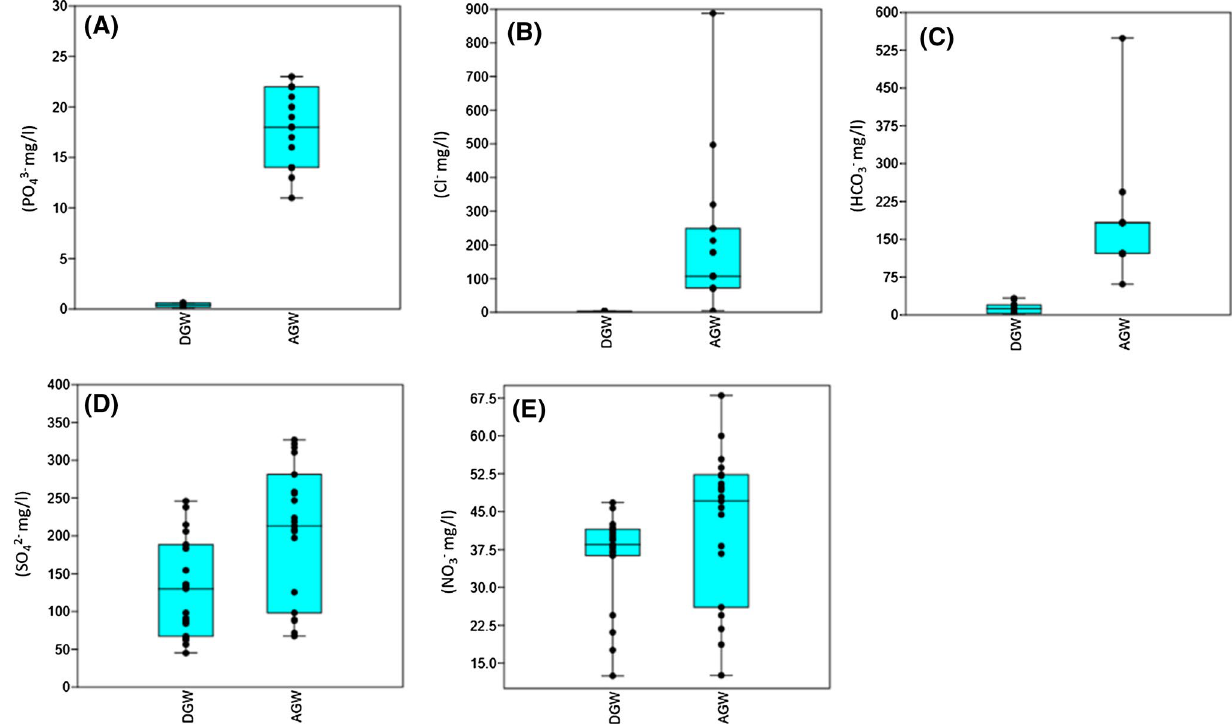
Fig. 7 Variability of anions a phosphate; b chloride; c bicarbonate; d sulfate; e iron; and f